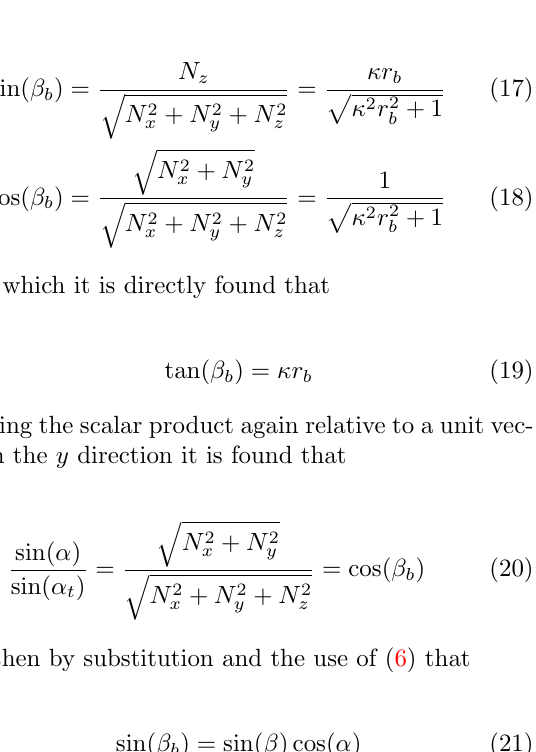
value along the involute shape. Due to the small con- tact zone width the assumption of Hertzian cylinder contact stress is still valid.